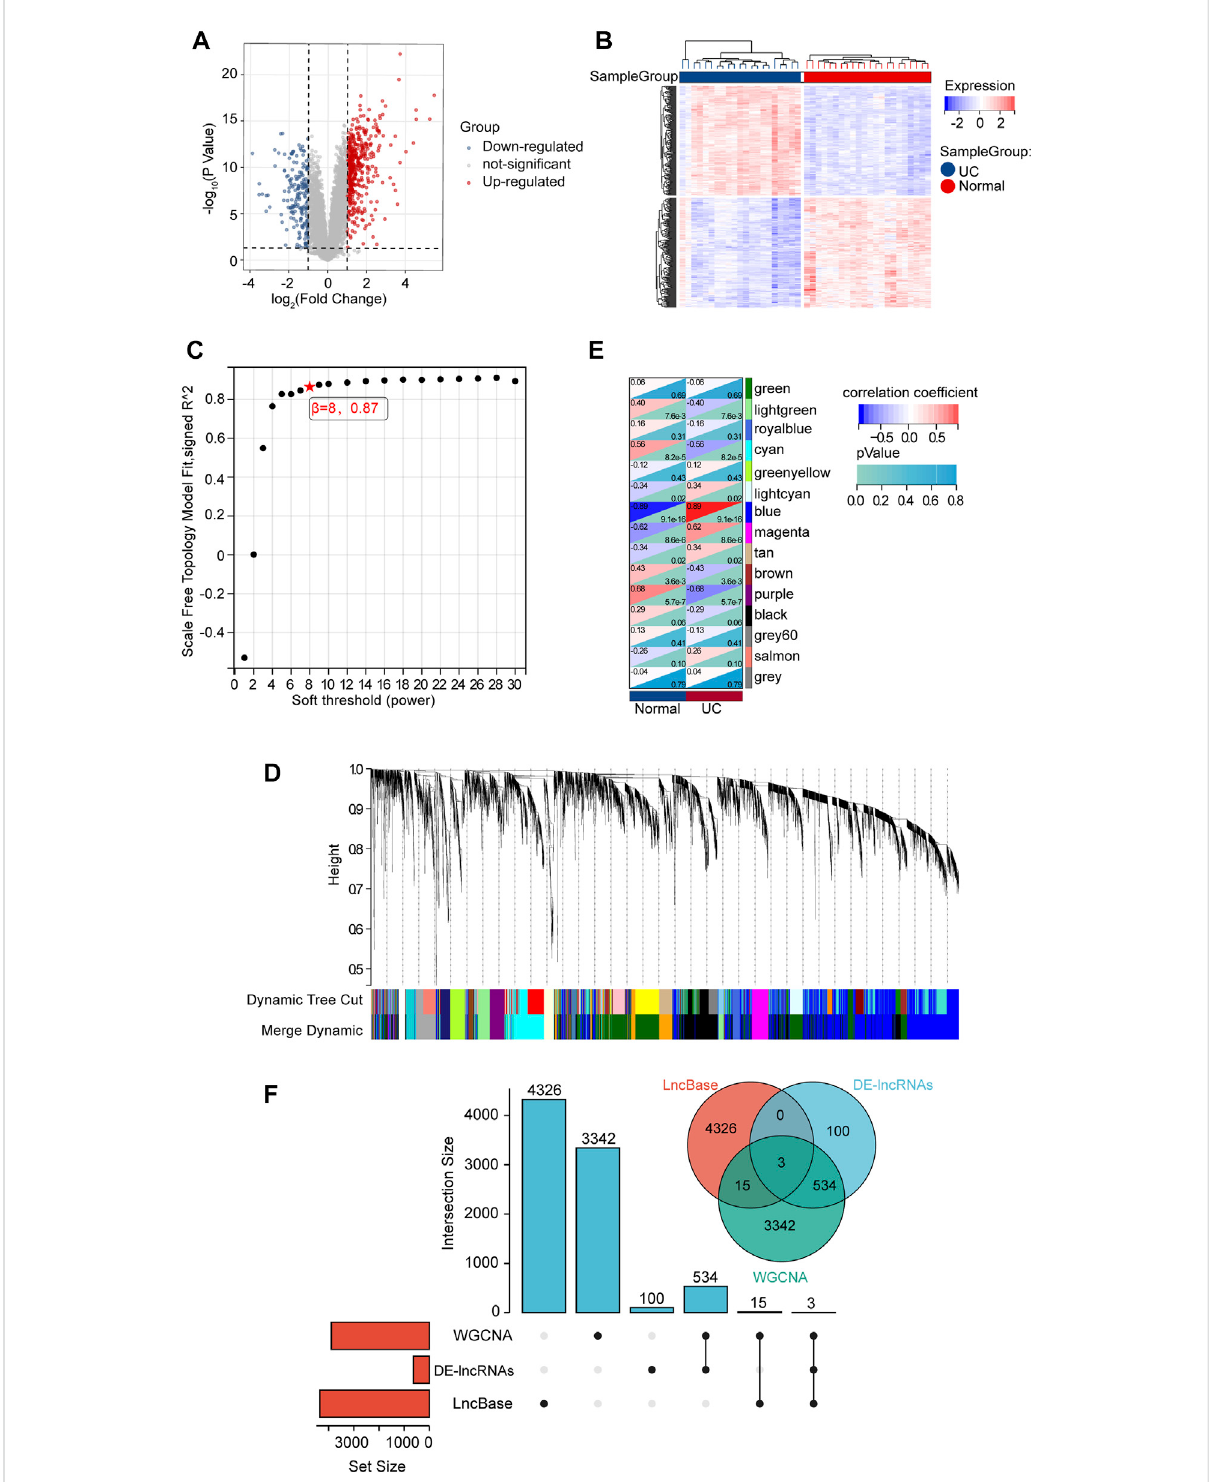
FIGURE 6 DE-lncRNA screeningand identi fi cationofcandidate overlapping DE-lncRNA. (A) Volcano plots ofDE-mRNAs fromGSE67106. (B) Heatmapof DE-mRNAs from GSE67106. (C) Determination of soft-thresholding power. (D) Clustering dendrogram. (E) The module-trait relationships. (F) The intersection of DE-lncRNAs, WGCNA modules, and